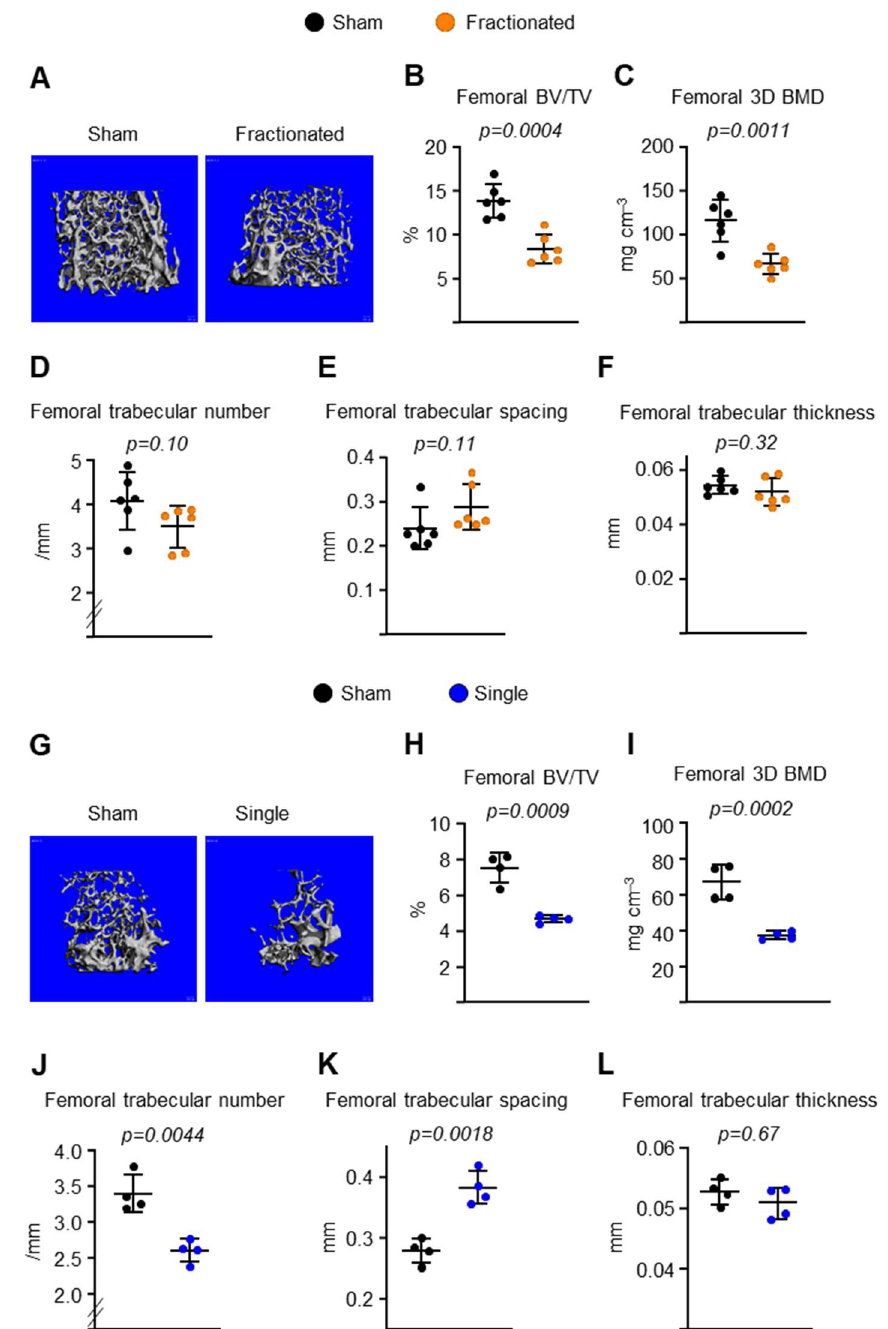
Figure 2. Loss of trabecular bone mass in femur following fractionated and singular TBI exposure. Imaging and quantification of femoral bones from sham and IR-exposed male mice by micro-CT after sacrifice ( n = 4–6 animals/group). ( A , G ) Representative 3D trabecular bone images of femur from ( A ) 8.5- and ( G ) 10-month-old male C57BL/6 mice. ( B , H ) Bone volume over tissue volume (BV/TV), ( C , I ) bone mineral density (BMD), ( D , J ) trabecular number, ( E , K ) spacing, and ( F , L ) thickness of trabecular bone measured in the femur of irradiated mice and sham controls by µCT. Data are presented as ±SD. p values were determined using Student’s t test.